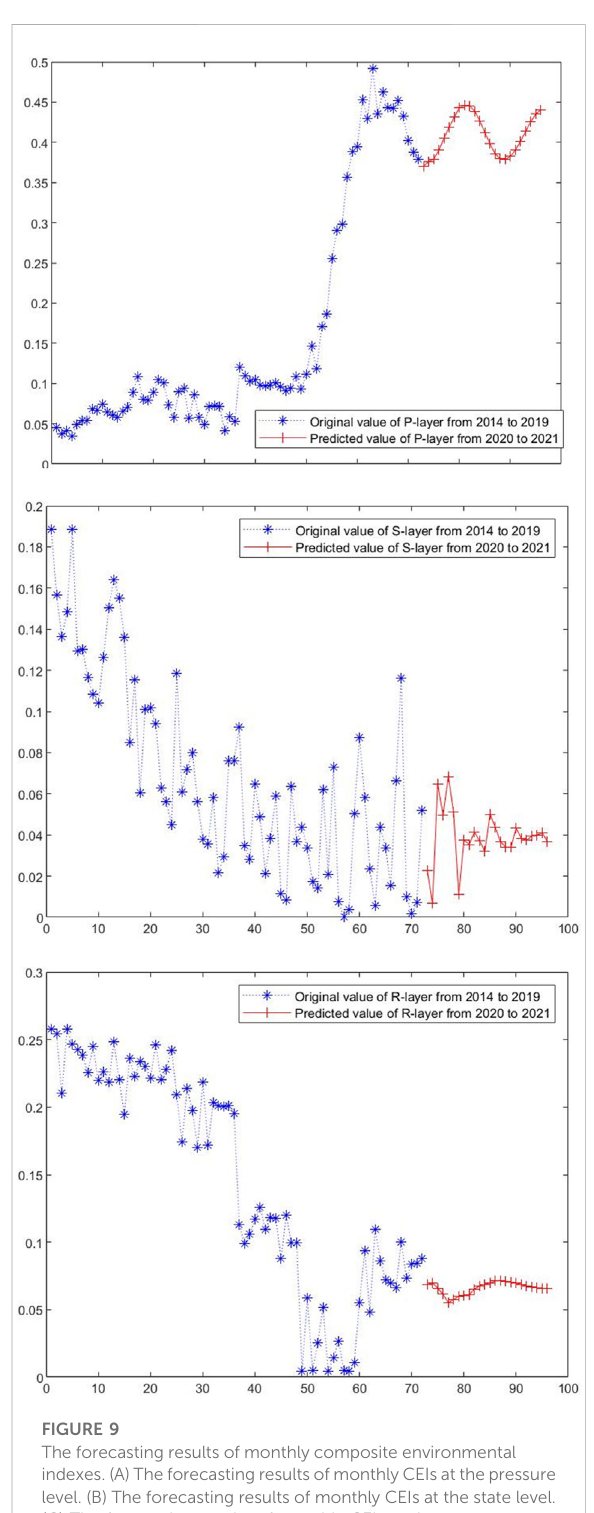
FIGURE 9 The forecasting results of monthly composite environmental indexes.(A)Theforecastingresultsofmonthly CEIsatthepressure level. (B) The forecasting results of monthly CEIs at the state level. (C) The forecasting results of monthly CEIs at the response